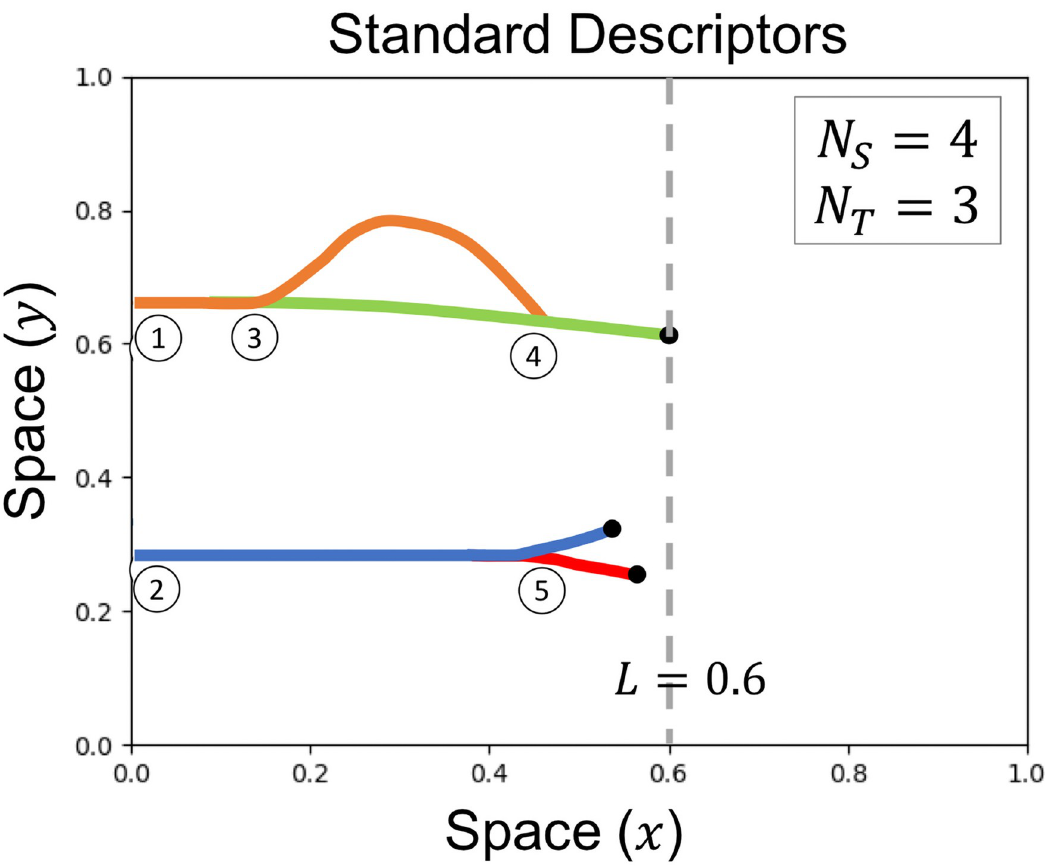
Fig 3. Standard descriptor overview. Standard descriptors are computed for each model simulation include the number of vessel segments ( N S , depicted by each colored solid curve), the number of endothelial tip cells ( N T , depicted by black dots), and the x - coordinate of the vessel segment location with the greatest horizontal distance from the y -axis ( L , depicted by the vertical grayed dashed line). This schematic example is initialized with 2 vessel segments and 2 tip cells at locations (1) and (2). A branching event at location (3) increases the value of both N and N by one. An anastomosis event at location (4) decreases N S T event at location (5) increases both N and N by S T